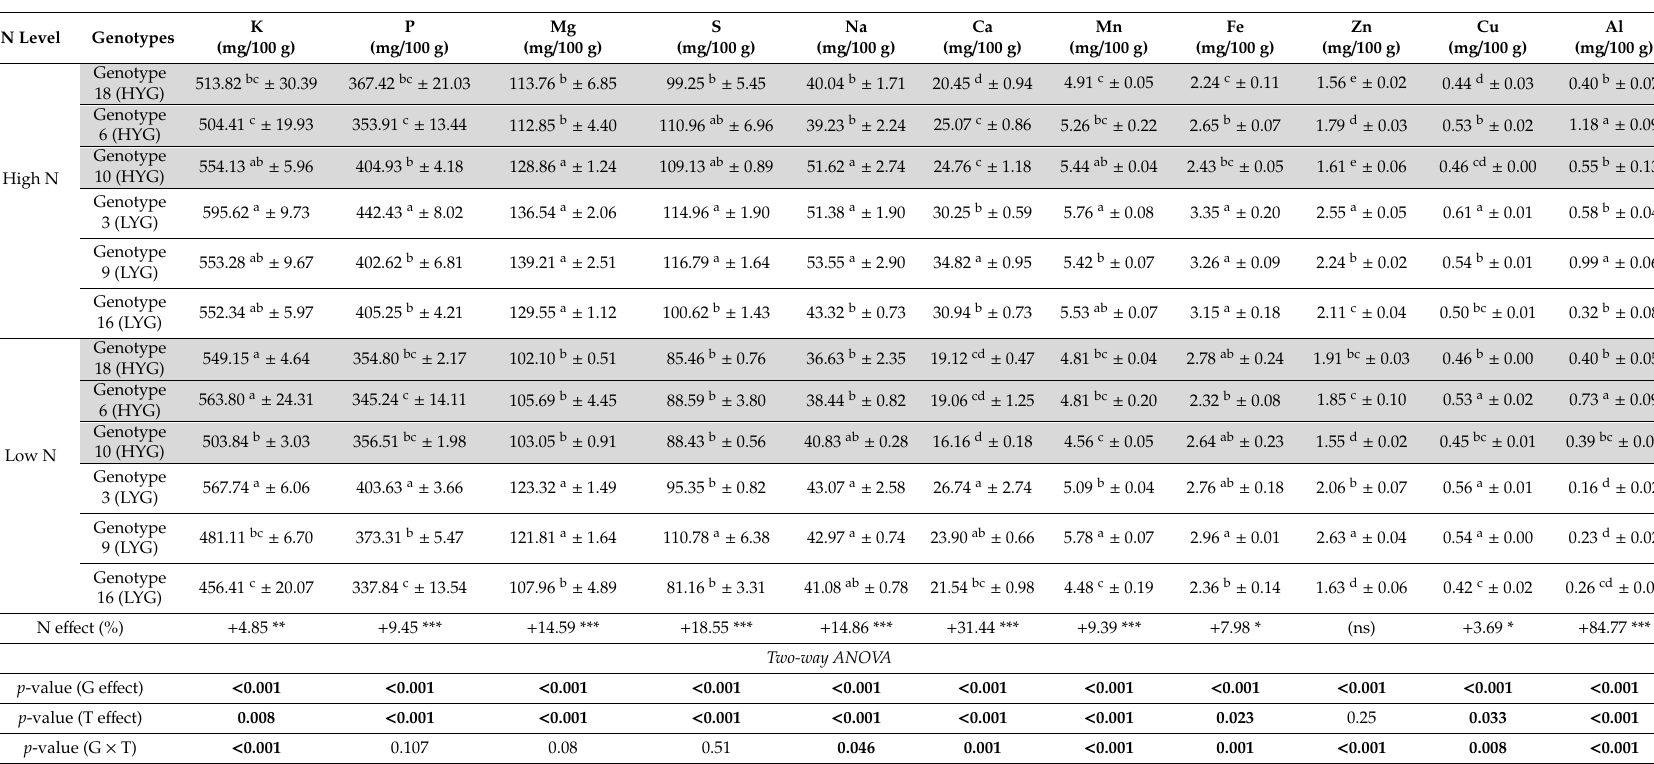
Table 4. Grain micro- and macro-nutrients of 6 wheat genotypes fertilized by two nitrogen levels (High and Low). Means are followed by standard error (n = 4). N